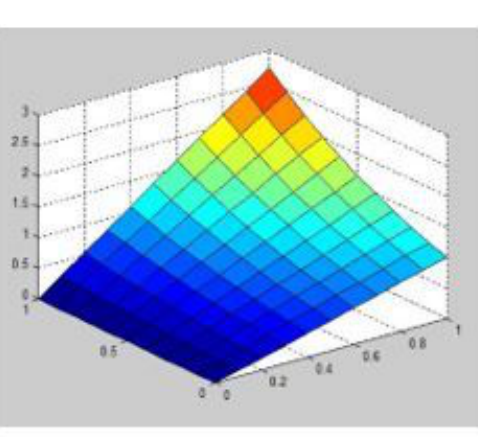
Figure 1: Approximate solution of Eq. (11) using